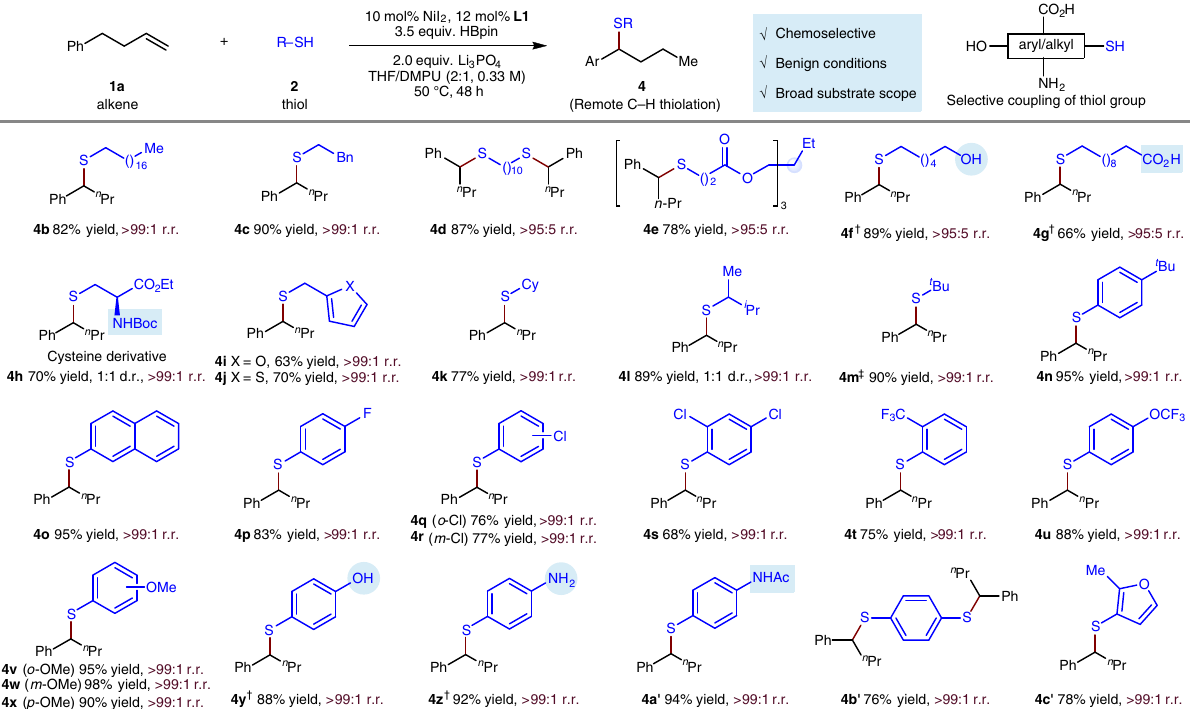
Fig. 4 Substrate scope of thiol partner. Under each product is given yield in percent, and either the regioisomeric ratio (r.r.) or the diastereomeric ratio (d.r.). Yield and r.r. are as de fi ned in Fig. 3 legend. † 5.0 equiv. HBpin was used. ‡ Di- tert -butyl disul fi de (0.10 mmol, 0.50 equiv.) was used. Boc, tert -butoxycarbonyl; Ac, acetyl; DMPU, 1,3-dimethyl-3,4,5,6-tetrahydro-2(1 H